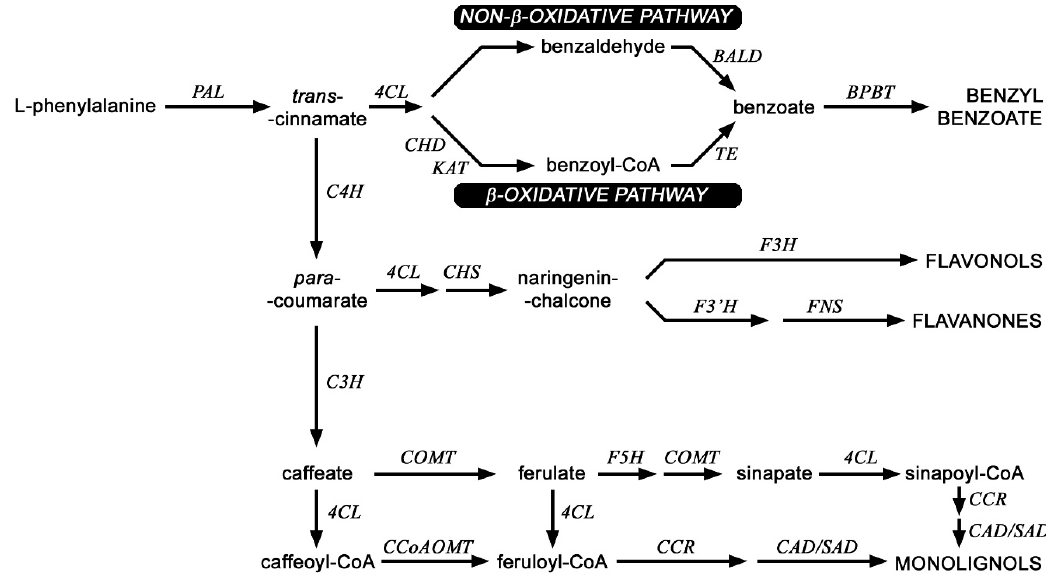
Figure 6. Scheme of selected routes of phenylpropanoid pathway in flax. PAL (phenylalanine